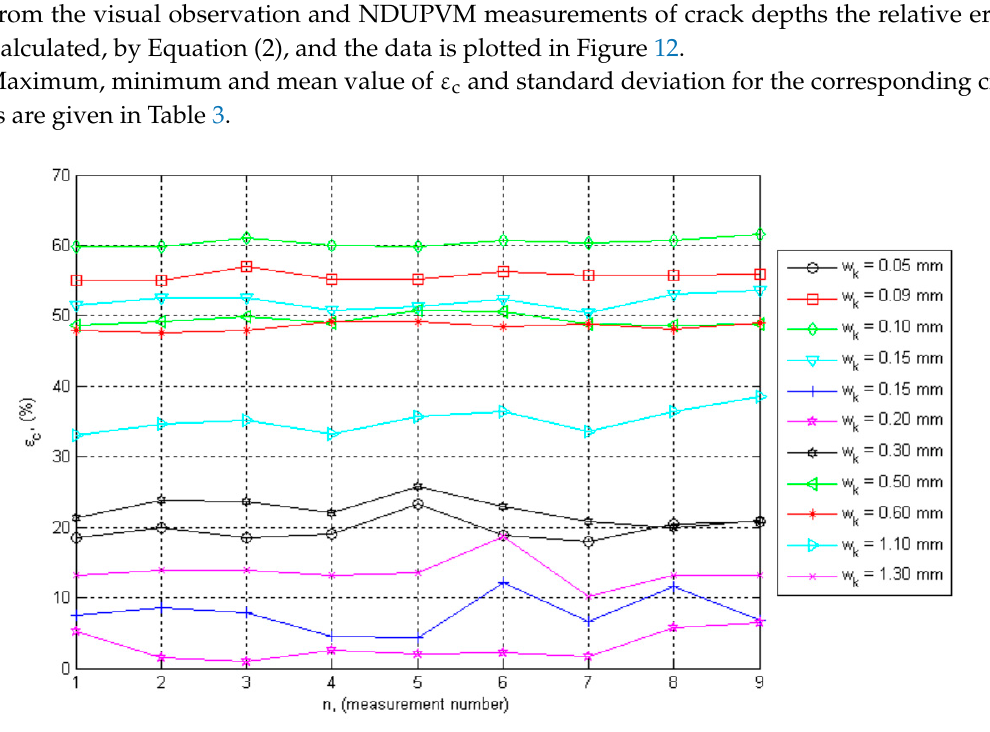
Figure 12. Relative errors ε c for visually determinate and NDUPVM crack depths for the corresponding crack widths.